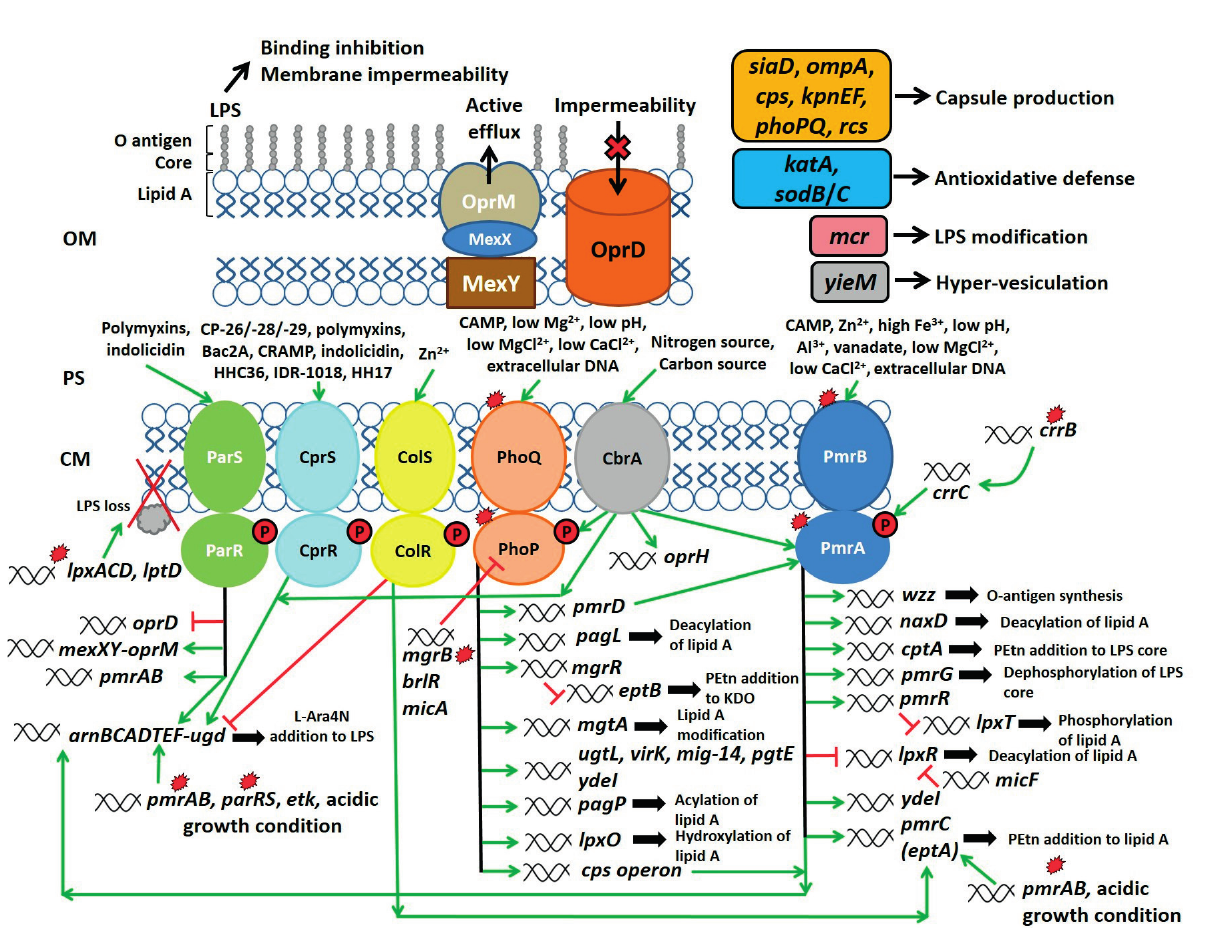
Fig. 1. Proposed polymyxin resistance mechanisms in bacteria. PhoP-PhoQ, PmrA-PmrB, ColR-ColS, CprS-CprR, ParS-ParR and CbrA-CbrB two-component systems confer bacterial resistance to polymyxin. Diagram of gram-negative cellular envelope, which shows typical inner and outer double layer separated by a periplasm (OM, outer membrane; PS, periplasmic space; CM, cytoplasmic membrane). The outer layer of the outer membrane contains a lipopolysaccharide (LPS), which is anchored to the membrane by the LPS lipid A. The inner layer of the outer membrane and also the entire inner membrane are composed only of phospholipids and the two bilayers can contain a variety of different types of membrane proteins. The figure shows different stimuli that induce various membrane and cytoplasmic proteins which then positively or negatively regulate other proteins. PhoPQ two-component system is activated (green arrow) by cationic antimicrobial peptides (CAMP), low Mg 2+ , low pH, low MgCl 2+ , low CaCl 2+ , extra- cellular DNA and mutations (denoted by red-colored star symbols) in phoP / phoQ . PhoPQ controls many genes required for LPS modification and alteration of the cell surface. These include the pmrD , pagL , mgrR , mgtA, ugtL, virK, mig-14, pgtE, ydeI, pagP, lpxO and cps operon. The activation of this two-component system mediates acylation, deacylation and hydroxylation of lipid A regulated by genes encoding the enzymes Pag, PagL and LpxO, respectively. The expression of EptB (phosphoethanolamine transferase) is suppressed (red line) with MgrR, while EptB is associated with the phosphoethanolamine addition to 3-deoxy-D- manno-oct-2-ulosonic acid (KDO). The lipid A is further modified by mgtA . Transcription of the genes ugtL , virK , mig-14 and pgtE participate in the mediation of polymyxin resistance and have functions associated with the alteration of the bacterial envelope. PhoPQ, as well as PmrAB, are required for the induction of ydeI which contributes to polymyxin resistance through its interac- tion with an outer membrane porin OmpD/NmpC. Additional cps genes are required for synthesis of polysaccharide capsule and be involved in the phosphorylation of Ugd. By contrast, MgrB, BrlR and MicA apply negative feedback to the PhoPQ regulatory system. With the help of PmrD, CbrA and in the presence of CAMP, Zn 2+ , high Fe 3+ , low pH, Al 3+ , vanadate, low MgCl 2+ , low CaCl 2+ and extracellular DNA, transcription of PmrA-activated gene is induced by PmrAB system. PmrA-P activates transcrip- tion of LPS modification loci (i.e., wzz , naxD , cptA , pmrG , pmrR , ydeI , pmrC , and arnBCADTEF-ugd ), except for lpxR , which is downregulated. Synthesis of the O-antigen is controlled by the wzz gene products. The NaxD and LpxR proteins are responsible for the deacylation of lipid A. However, MicF causes downregulation of LpxR synthesis, which is associated with deacylation of lipid A. The initiation of transcription of lpxR may play a role in resistance to polymyxin, but its effect on the resistance has not yet been demonstrated. Further, the CptA protein and PmrG regulate the phosphorylation modification of heptose-I and heptose-II residues on the LPS core, respectively. Likewise, PmrR inhibits the activity of lpxT , which phosphorylates lipid A. Additionally, phosphorylated PmrA activates the arnBCADTEF-ugd and pmrC genes, which modify LPS with 4-amino-4-deoxy-L- arabinose (L-Ara4N) and lipid A with PEtn, respectively. Moreover, also mutations in pmrA , pmrB and crrB genes through